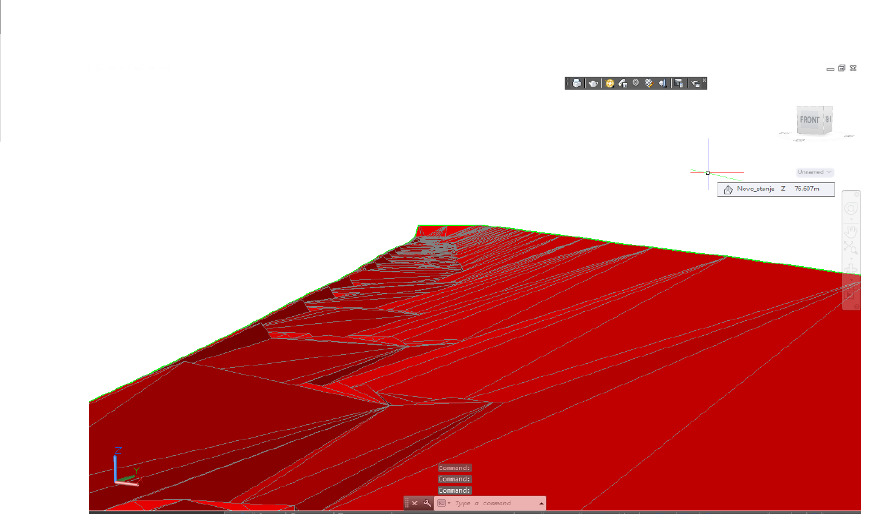
Figure 13 – 3D model view in a realistic form Рис . 13 – Изображение 3 Д модели в реалистичной форме